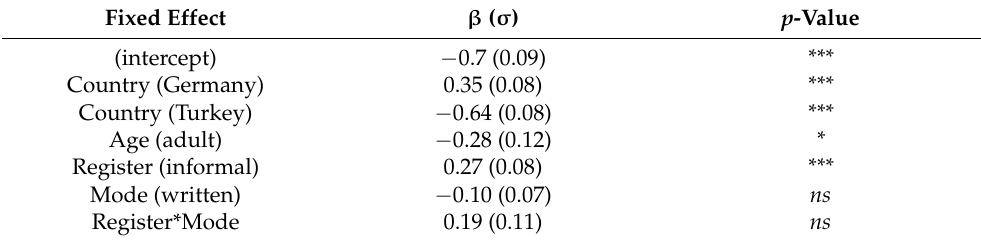
Table 3. Regression table for binomial GLMM with the dependent variable Connector and the independent variables Country, Age, and the interaction of Register and Mode.